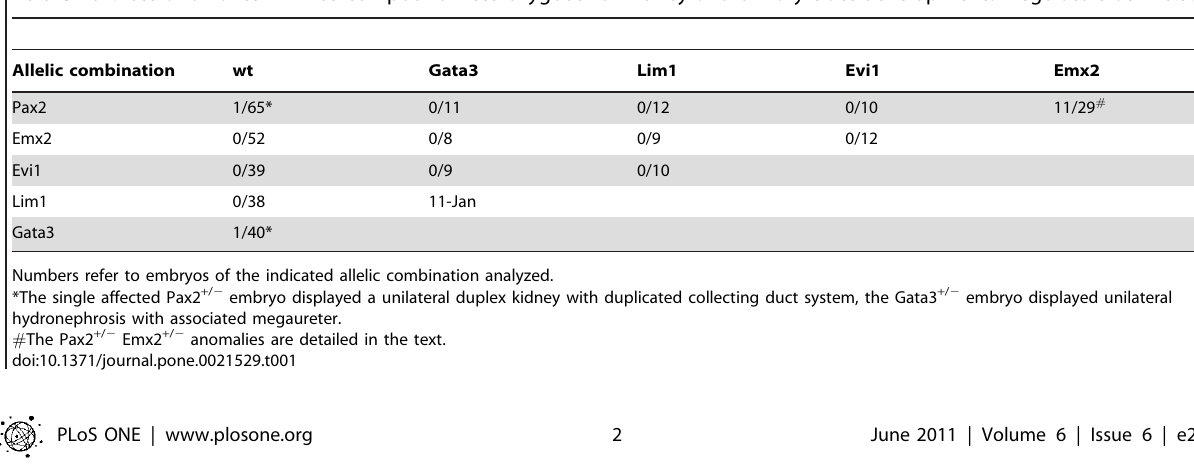
Table 1. Gross anomalies in mice compound heterozygous for kidney and urinary tract developmental regulators at E18.5.